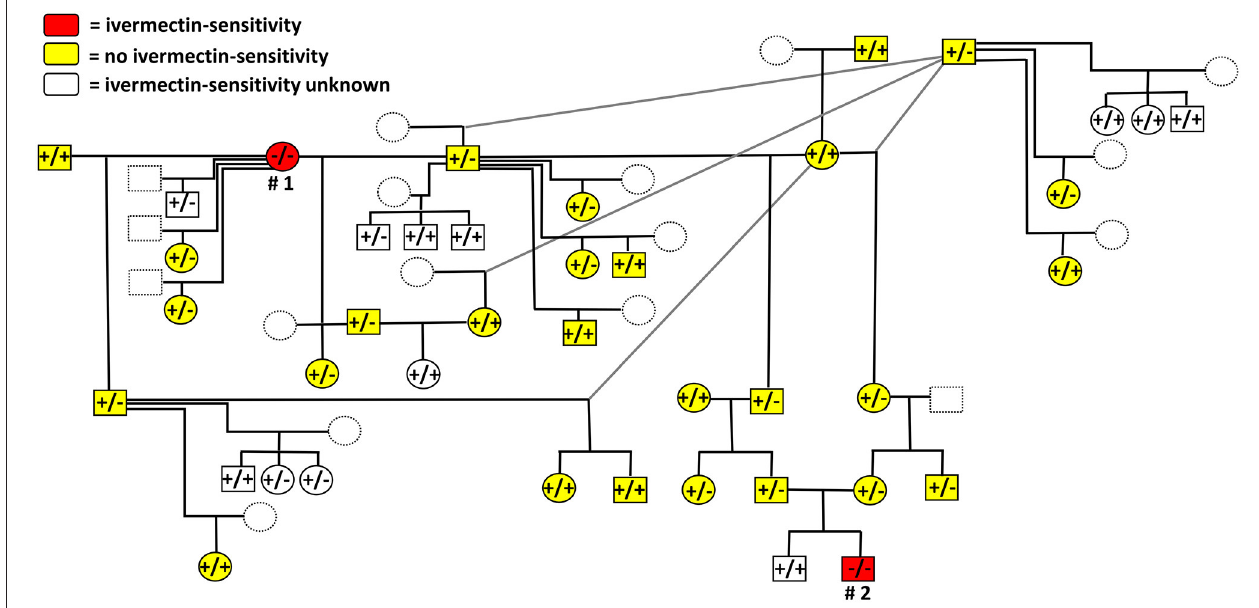
FIGURE 3 | Schematic and exemplary illustration of the anonymized pedigree, MDR1 genotypes and drug-sensitive phenotypes of the cats analyzed in the present study. Documented drug-sensitivity is indicated by red color for the ivermectin-sensitive female (# 1) and male (# 2) Maine Coon cats. Cats without history of neurological toxicity after ivermectin treatments in the past are indicated in yellow. Within the pedigree, circles represent females and boxes represent males. Individual genotypes are indicated as follows: MDR1( + / + ), homozygous wild-type; MDR1( + /-), heterozygous mutant or MDR1(-/-), homozygous mutant for the genotype ABCB1 1930_1931del TC. Dotted lines were used for cats that were not sampled/genotyped. For better clarity, only a limited number of 41 out of the overall 54 related cats were included in this